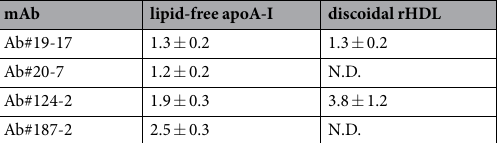
Table 1. K D values (nM) for single-antibody ELISA shown in Fig.